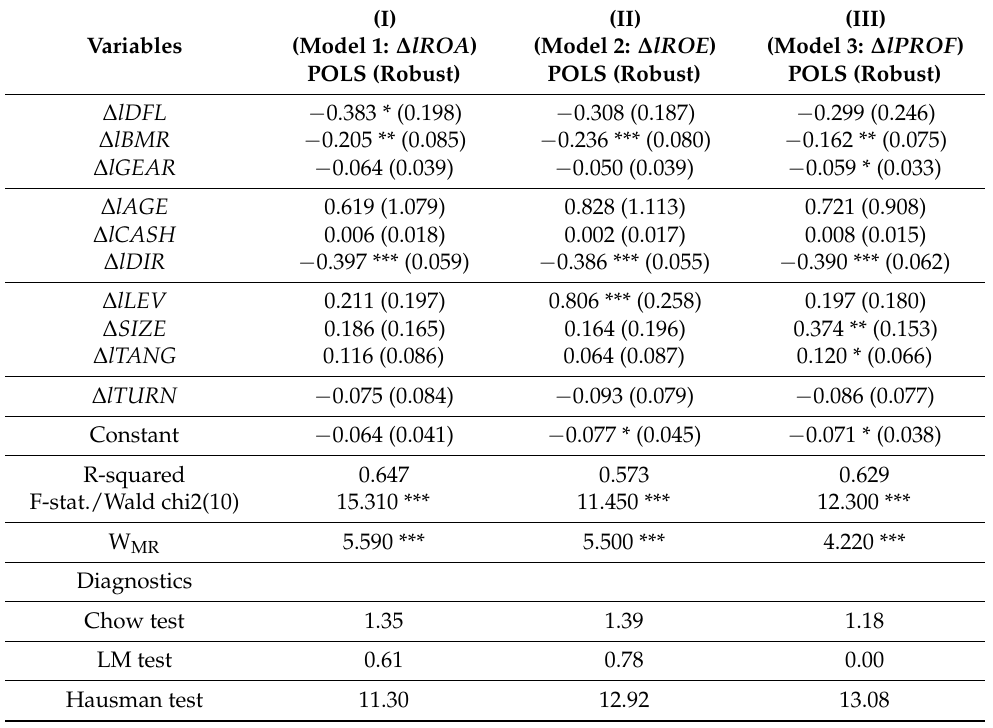
Table 4. The effect of market risk on financial